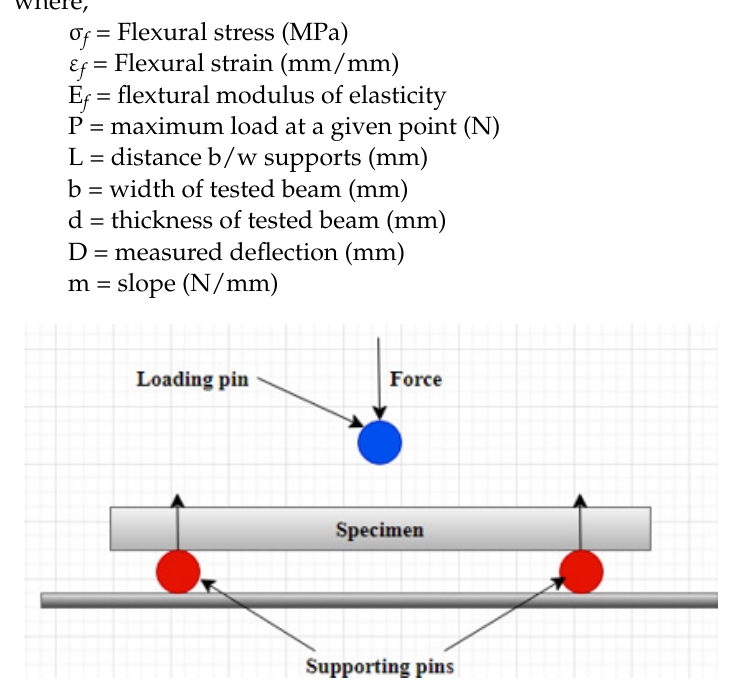
Figure 8. The schematic diagram of three-point flexure testing using a sample with dimensions 80 mm × 10 mm × 4 mm (L × W × H).